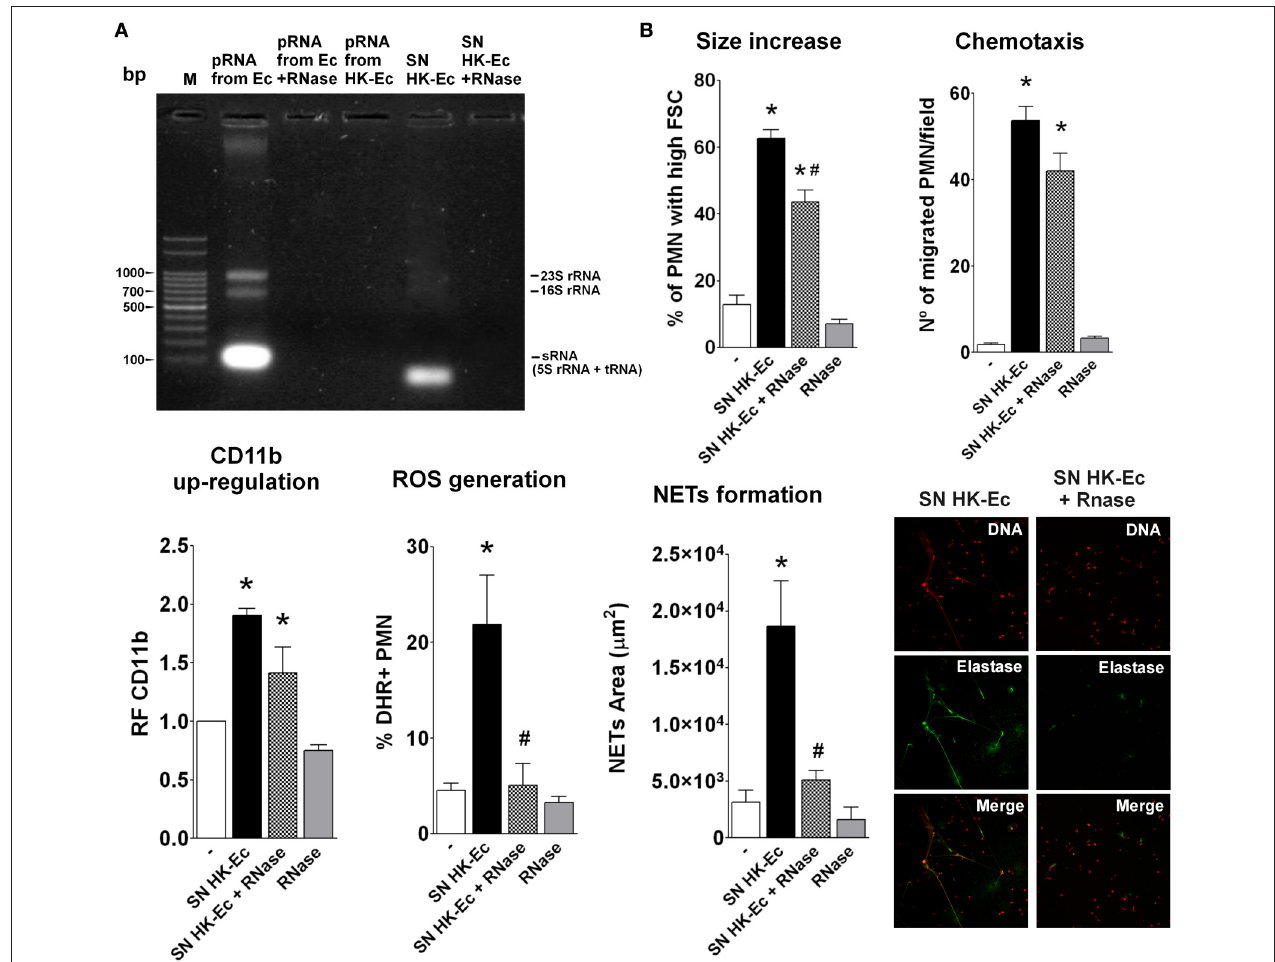
FIGURE 3 | Death caused the release of RNA from bacteria. (A) Agarose gel electrophoresis stained with ethidium bromide. M-Marker: 100 bp Plus DNA ladder. (B) PMN activation was determined using the bacteria-free supernatants (SN) of HK-Ec, the SN treated with RNase (SN HK-Ec + RNase) and RNase alone by measuring different functions as detailed for Figures 1 , 2 . Results were expressed as the mean ± ES, n = 5. * p < 0.05 vs. non-treated PMN ( − ), # p < 0.05 vs. SN